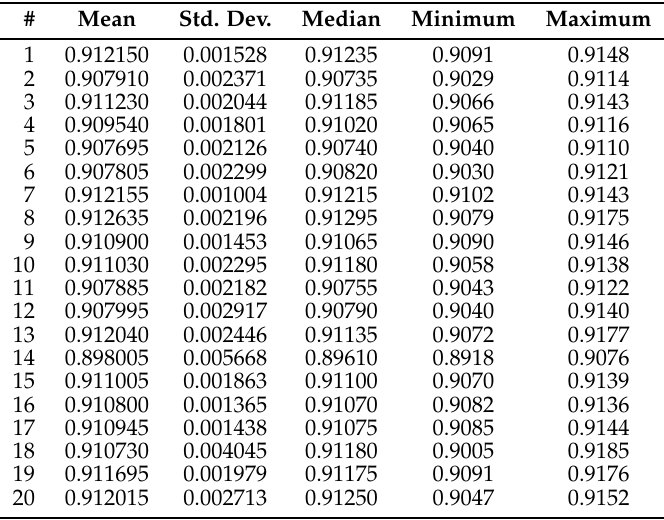
Table 6. Summary of F1 scores of the best 20 GE individuals after full training in the OPPORTUNITY Gestures